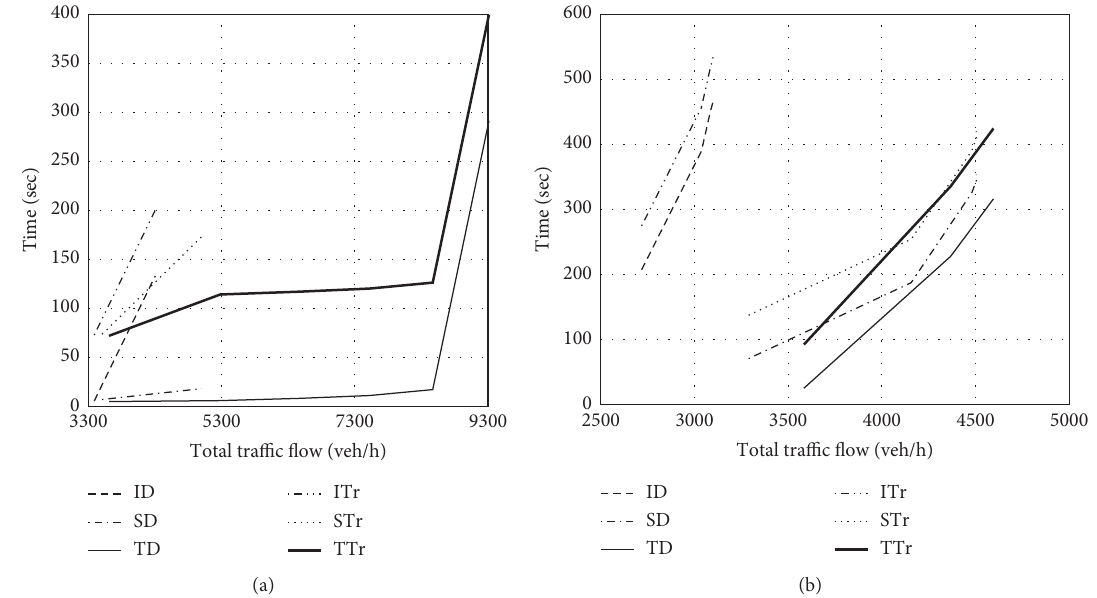
Figure 4: The total travel time of the intersection. (a) Unsignalized. (b)